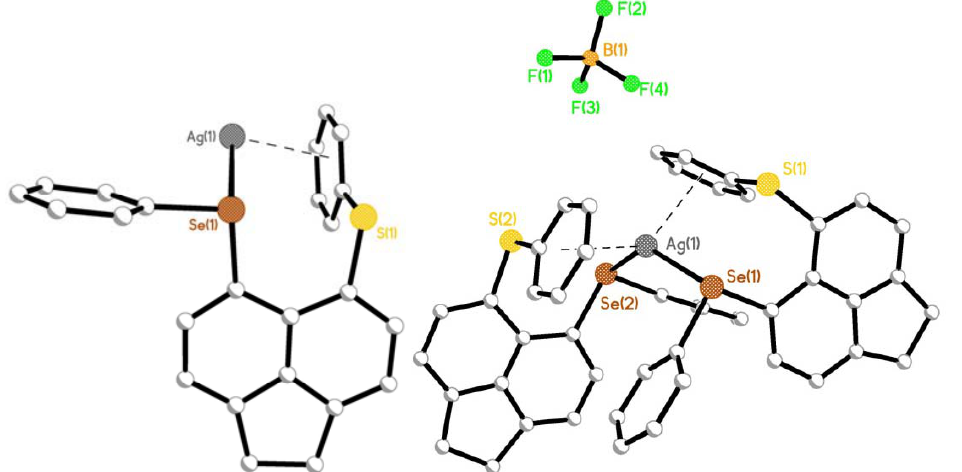
Figure 3. Two crystallographically distinct L1 ligands bind to the silver(I) center via monodentate selenium coordination (left) to form complex 1 (right; H atoms and solvent molecules omitted for clarity). The structures of 2 and 3 (adopting similar conformations to 1 ) are omitted here but can be found in Figure S1 in the